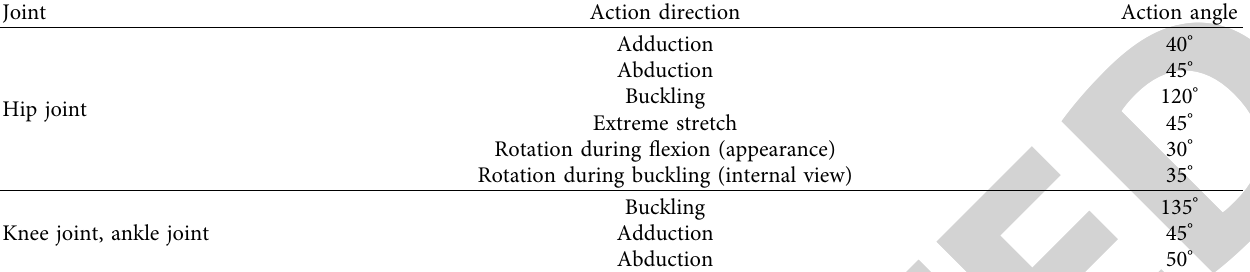
Table 1: Motion boundary table of various parts of human lower limbs.